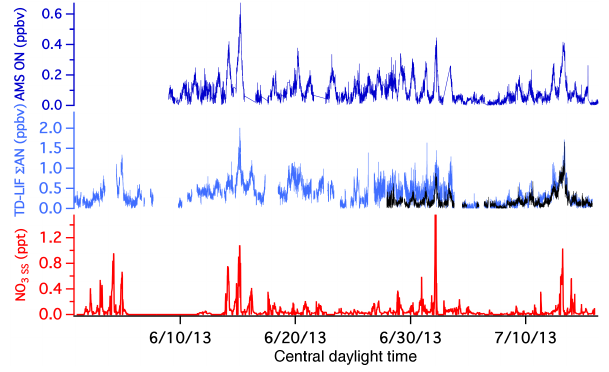
Figure 2. Nitrate radical concentration estimated by the steady- state approximation (red trace) shows several instances where peaks in NO 3 concentration correspond to times of (cid:54) AN (gaseous + aerosol) buildup (light blue trace) from TD-LIF and par- ticle phase organic nitrate from AMS (dark blue). The black overlay in TD-LIF (cid:54) ANs is the aerosol-phase measurement of (cid:54) ANs and qualitatively shows that, when data are available, a large portion of the organic nitrates appear to be in the aerosol phase.